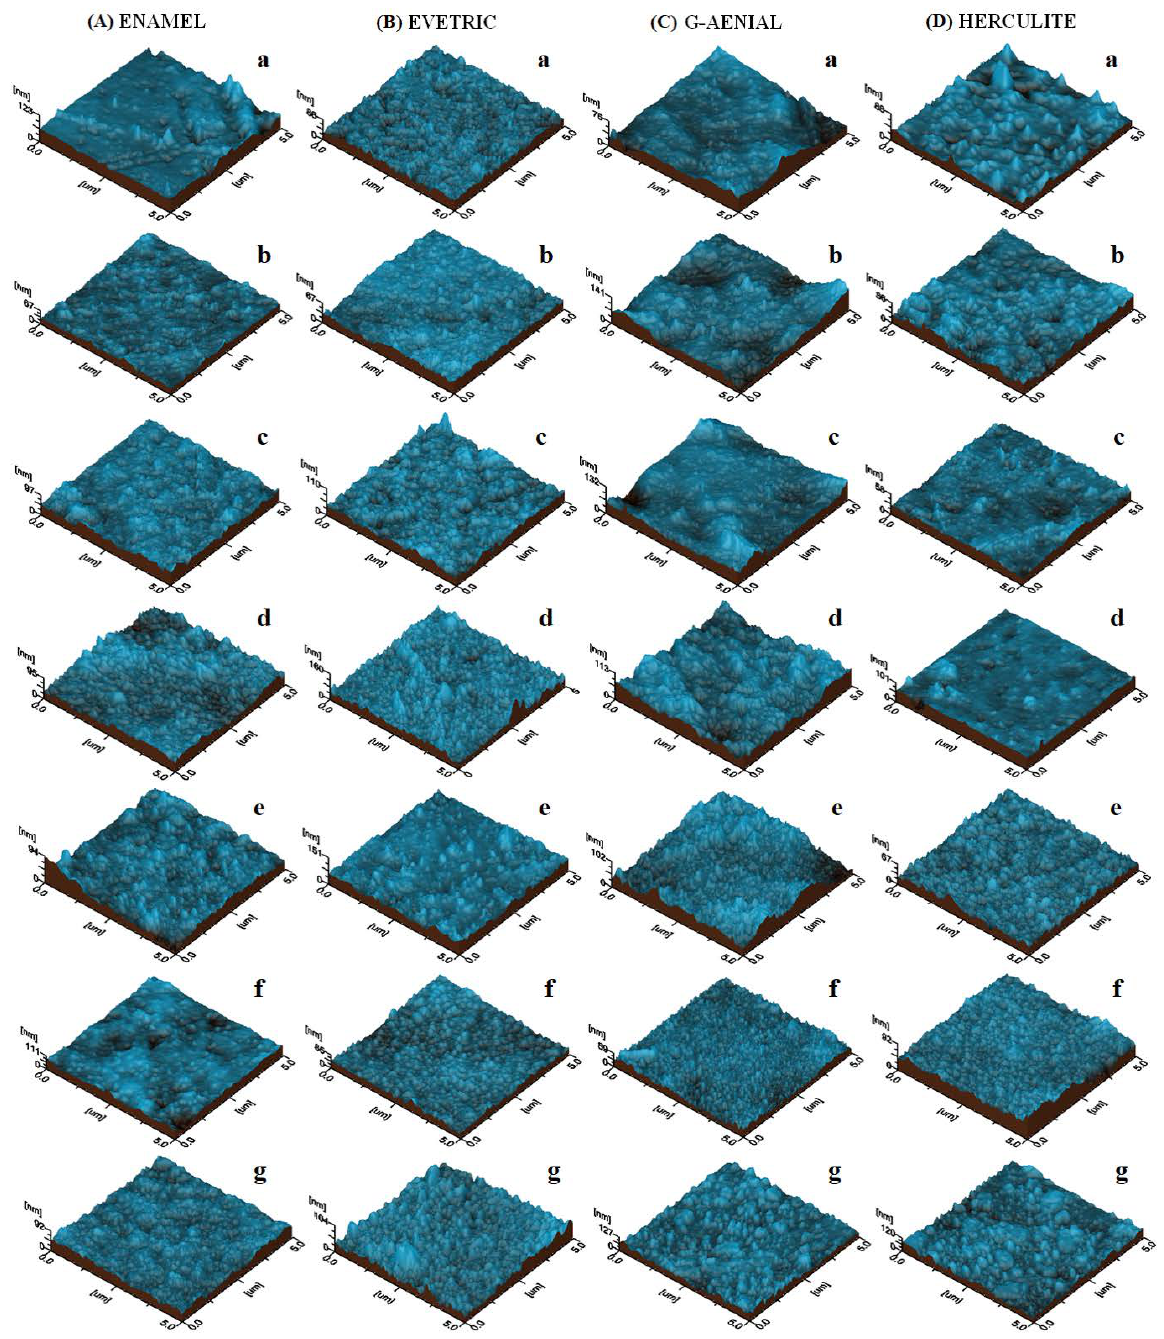
Figure 2. AFM 3D topographical images for dental materials: ( A ) Enamel, ( B ) Evetric, ( C ) G-aenial, and ( D ) Herculite exposed to various saliva: ( a ) untreated sample, ( b ) healthy, ( c ) artificial, ( d ) AML, ( e ) CML, ( f ) ALL, ( g ) CLL.